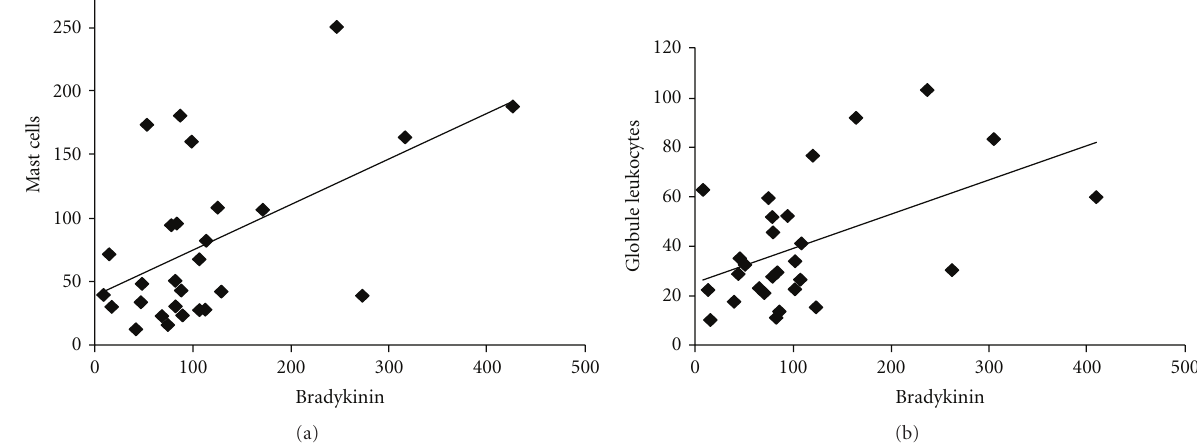
Figure 2: Relationships between the concentration of bradykinin in abomasal mucus and the numbers of mast cells ( r = − 0 . 53, P = 0 . 003, n = 28) and the numbers of globule leukocytes ( r = − 0 . 5, P = 0 . 006, n = 28) in the abomasum.